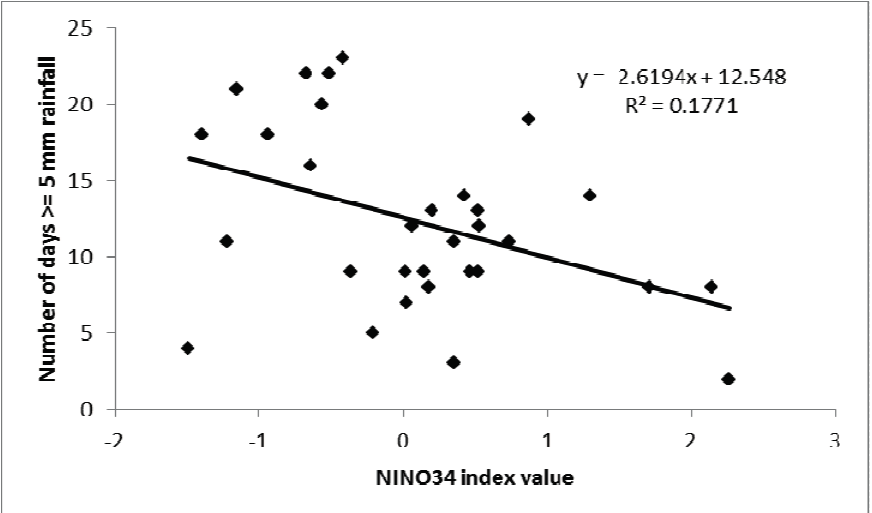
Figure 6. Number of days with ≥ 5 mm rainfall total at Mapalana,